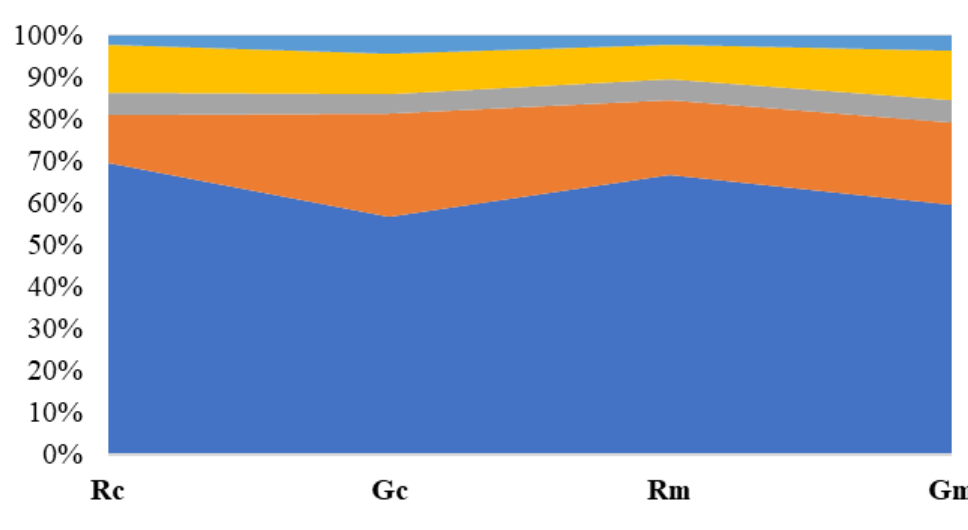
Figure 5. Rietveld quantification of crystalline phases on clinkers obtained by calcination of raw mixes with/without WG content: Rc and Gc—raw mix based on clay; Rm and Gm—raw mix based on marl. Rc and Rm were obtained by thermal treatment at 1450 ◦ C, 30 min; Gc and Gm were obtained by thermal treatment at 1430 ◦ C, 30 min.